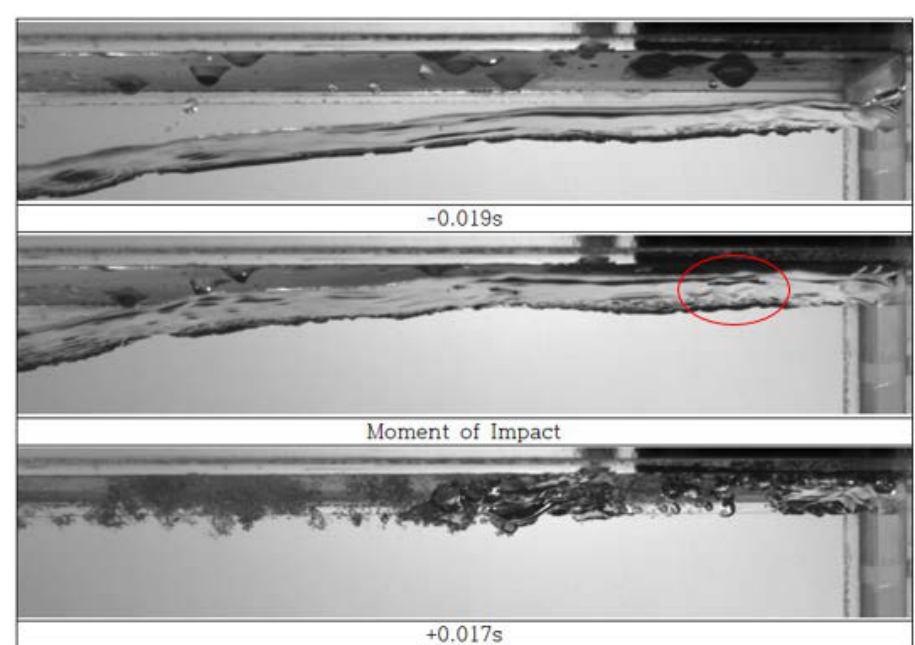
Figure 13. Snapshots at First Impact: SWAY (Wet).